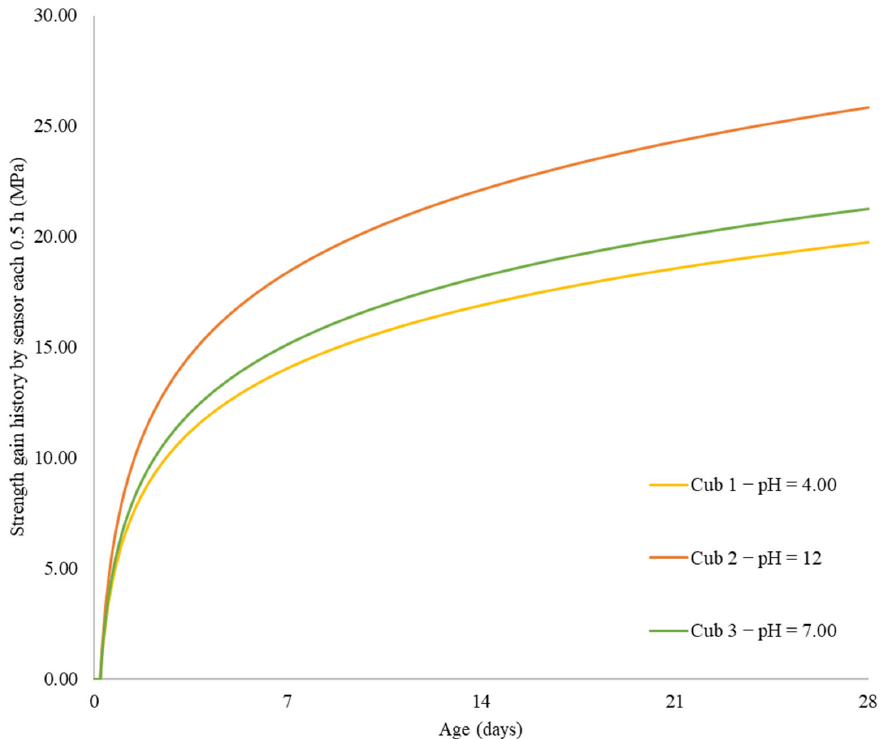
Figure 7. Strength gain data with time recorded by the sensor after every time interval of 0.5 h.